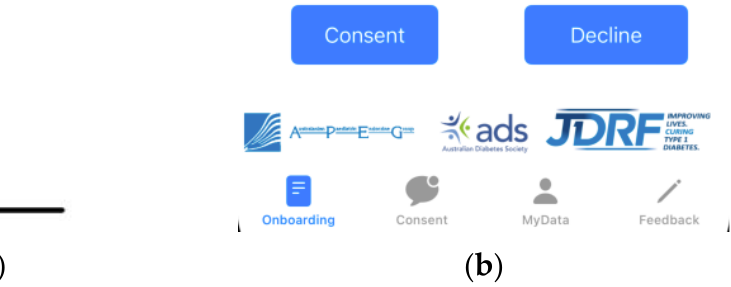
Figure 2. Screenshots of the ADDN Consent application. ( a ) Activation through an ADDN registry generated activation code. ( b ) Description of the ADDN project and basic onboarding documenta- tion .